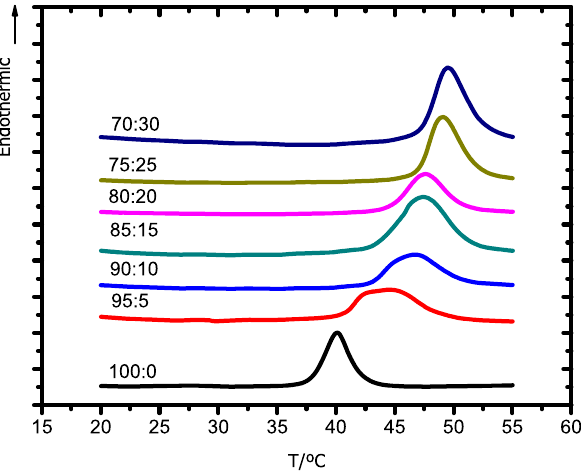
Figure 6. DSC thermograms of the DPPC:Chol:18-2-18 system for the lipid:surfactant molar ratios indicated. A scanning rate of 10 u C/min was used.